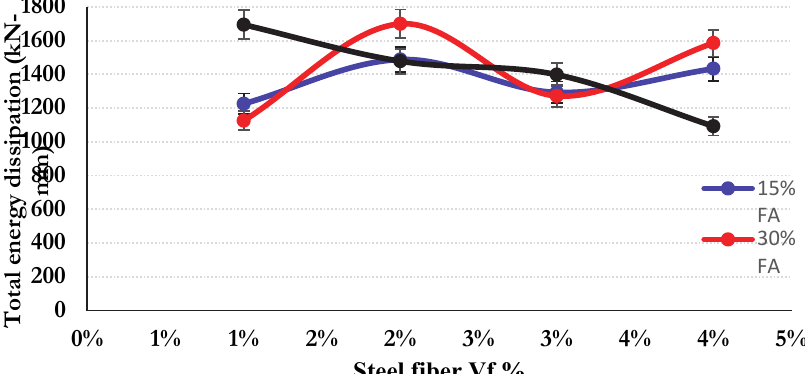
Figure 13: The effect of steel fiber volume fractions and fly ash on the total energy dissipation for all